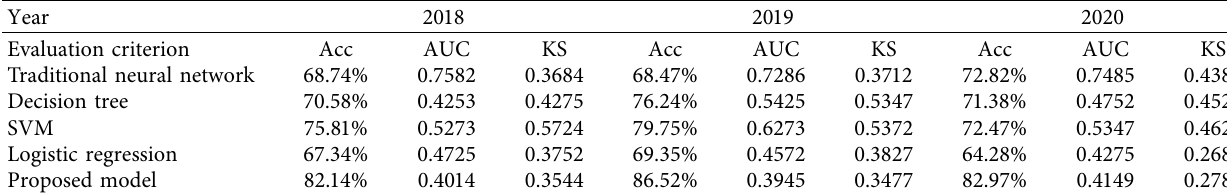
Table 3: Evaluation and prediction performance of diferent evaluation